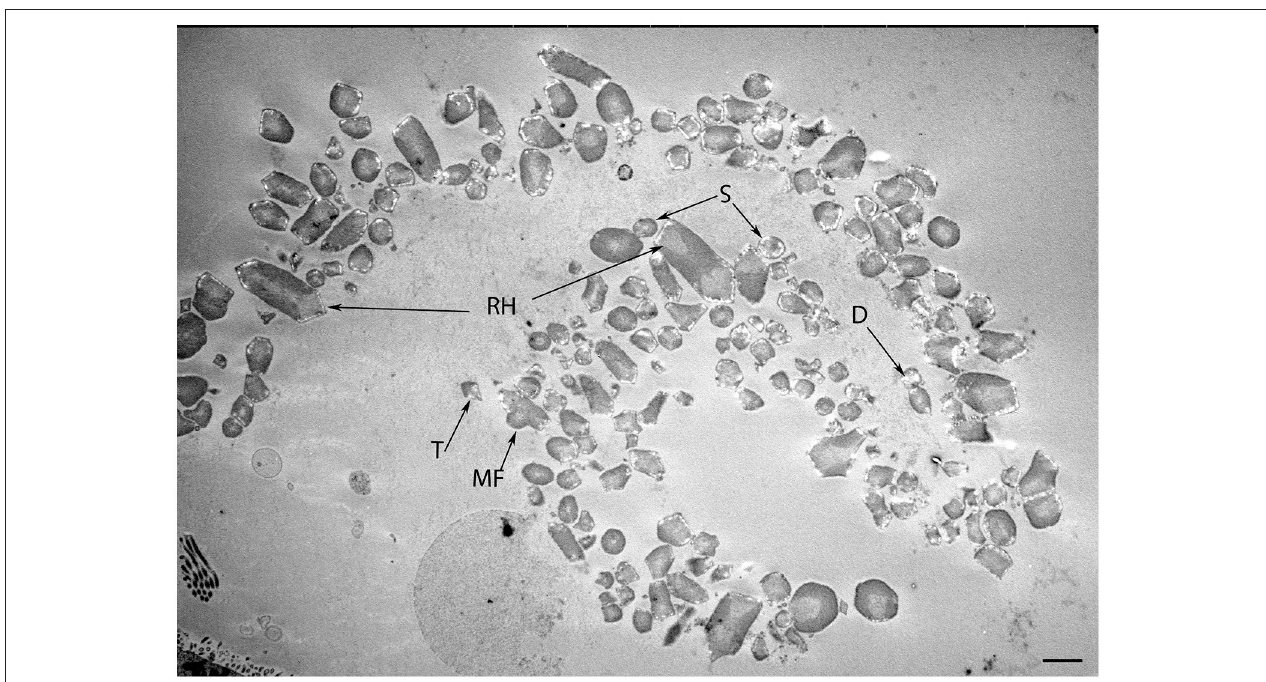
FIGURE 7 | Transmission micrograph image of the developing human fetal utricular otoconia in singlet (S), doublet (D), trigonal (T), multifaceted (MF), and rhombohedral (RH) shapes at W12 of gestation. Scale bar 10 µ